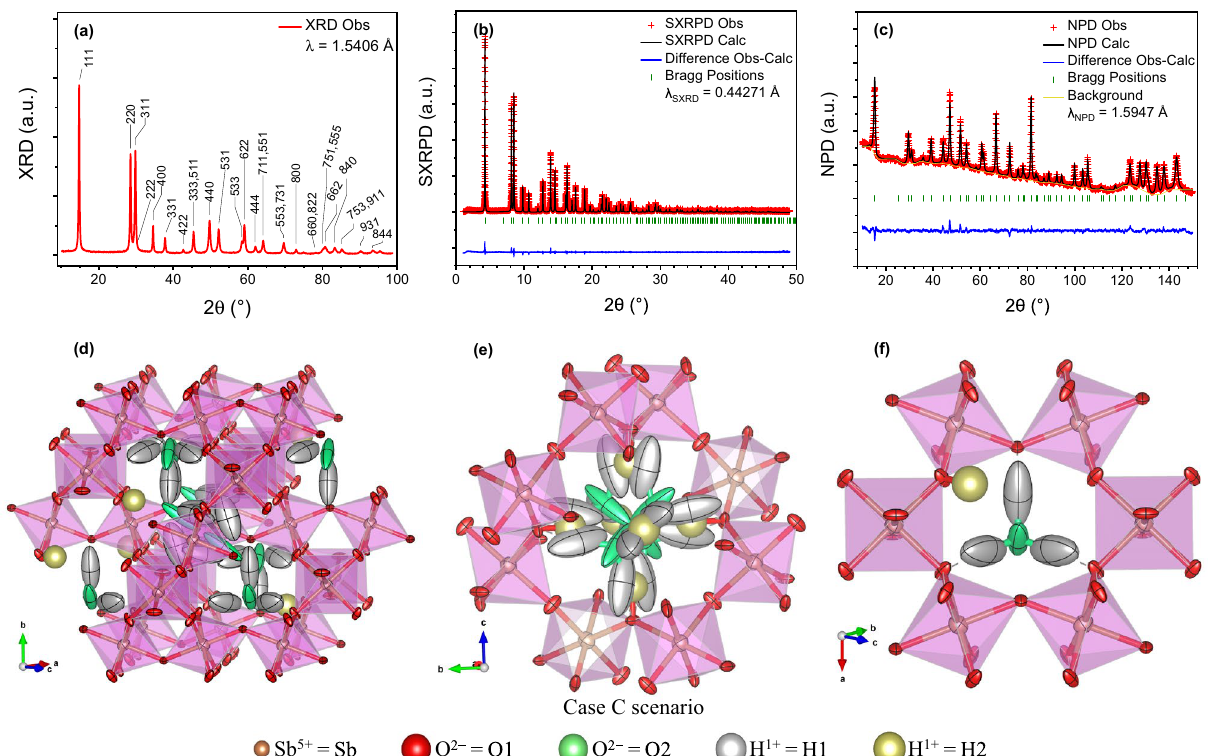
Figure 1. Diffraction patterns and structural representation of AA. ( a ) Laboratory XRD diagram of (H 3 O) 1.20(7) H 0.77(9) Sb 2 O 6 (λ = 1.5406 Å Cu Kα radiation) with peaks indexed in a face-centred cubic unit cell with a = 10.36052(15) Å. ( b , c ) Plots from the combined Rietveld refinement from SXRD and NPD data. Experimental (red crosses), calculated (solid black line), and difference (solid blue line at the bottom) ( b ) SXRD (λ SXRD = 0.44271 Å) and ( c ) NPD (λ NPD = 1.5947 Å) patterns, with Bragg reflection positions marked by vertical green bars. ( d – f ) Views of the AA pyrochlore final structure (‘Case C’ scenario described in the Supporting Information). Atoms of the three panels are presented as anisotropic displacement ellipsoids at a 95% probability level. Caption colour reference at the bottom of Figure is common to all figures. ( d ) Representation of a snapshot of the crystal approximately along the [ 101 ] direction: the covalent framework made by the (Sb 5+ O 6 ) corner-sharing octahedra consists of 16 d (Sb, brown) and 48 f (O1, red) fully occupied sites, with golden (H2) protons linked to the skeleton O1 atoms at distances of 1.13(6) Å. Hydronium subunits are constituted by silver (H1) protons bonded to green (O2) oxygens at 1.323(11) Å in a tetrahedral distribution (with 104.0(16)° angles). These atoms present high mobility, with prolate anisotropic ellipsoids oriented along the ( x , x , x ) main threefold diagonal. ( e ) Close up of the statistical distribution of a single cavity wherein the O2 and H1 are distributed at 32 e and 96 g Wyckoff positions, respectively, with SOFs close to 0.301(2), and H2 atoms at 48 f sites exhibiting a SOF of 0.129(15). Only 1.20(7) H 3 O + groups and 0.77(9) H2 species are statistically present in each cavity. ( f ) Snapshot of a single octahedra-sharing crown with a hydronium subunit and a H2 proton. In dotted lines: H1 atoms of the H 3 O + subunit establish H bonds with the O1 atoms at about 1.400(10) The crystallographic formula obtained from the structural refinement is (H 3 O) 1.20(7) H 0.77(9) Sb 2 O 6 , which pre- sents electroneutrality within the standard deviation and is also endorsed by the low Rietveld reliability factors and the reasonable equivalent isotropic displacement factors obtained for each mobile atom. It is interesting to examine the ionic conduction path obtained from a bond-valence energy landscape (BVEL) study of the crys- tal, illustrated in Fig. 2a–c. The conduction pathway, highlighted with a blue isosurface, involves both types of H atoms and exhibits an isotropic distribution along the three axes. The percolation of the H atoms presents a very low activation energy of 0.13 eV and a noticeably large volume fraction of the unit cell for ion mobility of 72.38% for the given parameters, providing the mechanism for the high ionic intracrystalline proton conduction announced by several authors 3,4,13,32 . The average site-energy computed by bond-valence theory for both mobile protons is − 2.95 eV, differing between both species in only 0.12 eV. The H2 atom is bonded to the framework in a Sb 5+ ‒ OH fashion, with hydroxyl interatomic distances H2 ‒ O1 of 1.13(6) Å. The O2 at 32 e Wyckoff sites is coordinated by three H1 species at 96 g positions in a tetrahe- dral arrangement, with internal H1 ‒ O2 ‒ H1 angles of 104.0(16)°. The lone electron pair of the oxygen atoms belonging to the hydronium groups are oriented in the 8 a ( 1 / 8 , 1 / 8 , 1 / 8 ) direction. The H1 atoms are located about 1.400(10) Å away from the O1 oxygen of the covalent framework, with which a hydrogen bond is likely estab- lished. Remarkably, the mean H1 ‒ O2 interatomic distance within the hydronium unit is 1.323(11) Å, which might seem rather large for a well-established (coordinated) covalent bond. The reason for this is that, statistically,